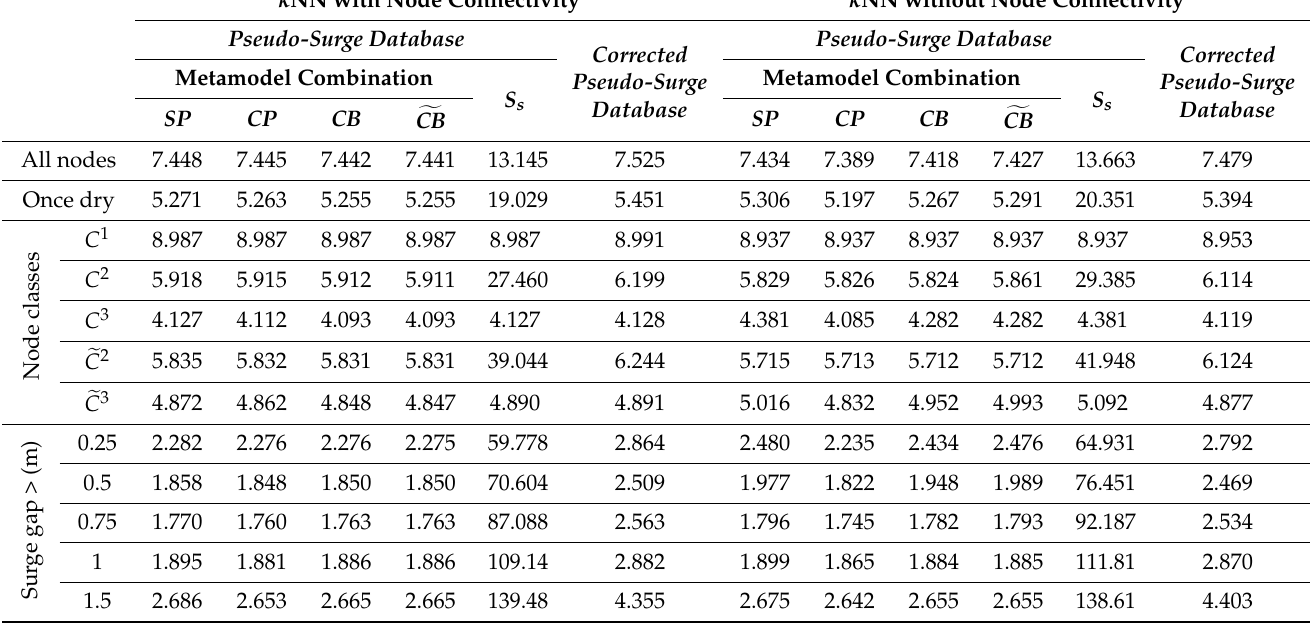
Table 7. Surge score SC (cm) averaged across different groups of nodes for different surrogate model variants for the implementation that considers different surge metamodels for different classes of nodes.